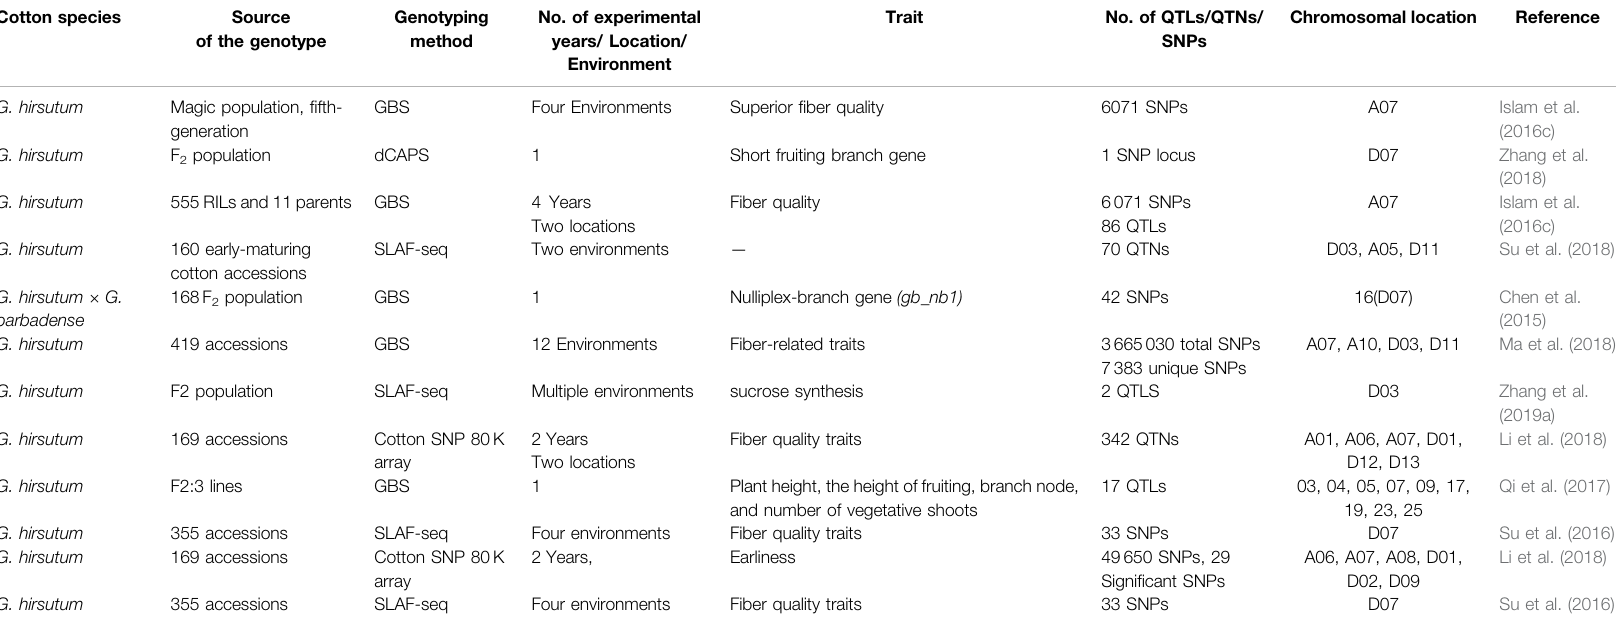
TABLE 3 | Role of SNPs for the determination of QTLs of fi ber quality traits across chromosome 7 in G. hirsutum Cotton